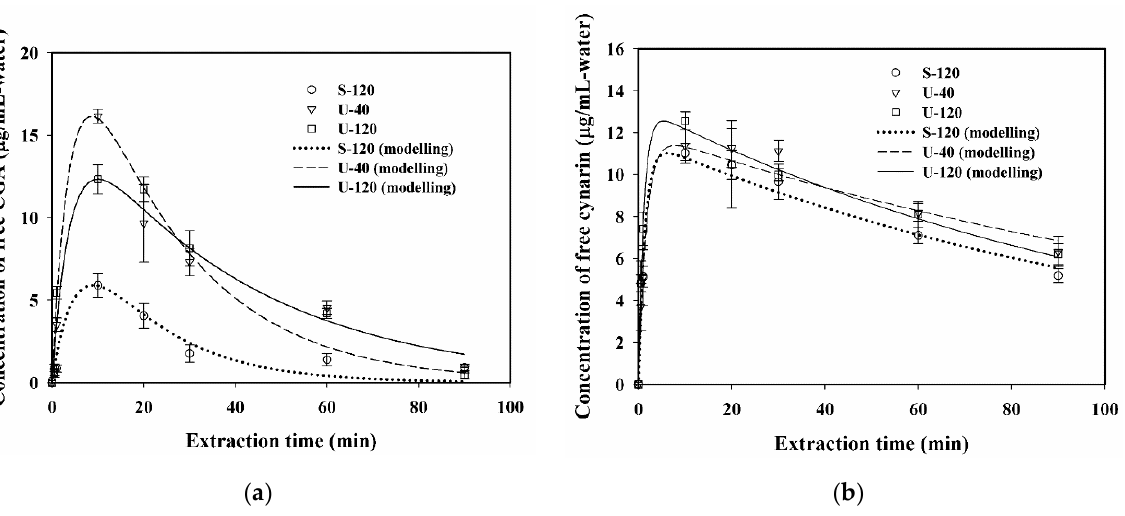
Figure 4. Plots of ( a ) concentration of free chlorogenic acid (CGA) and ( b ) concentration of free cynarin in water versus extraction time, and modelling the correlation of related kinetic parameters. Conditions: 50 °C and 1/30 (g/mL-water) of solid-to-liquid ratio for extraction modes of 120 rpm of shaking (S-120), 40 kHz/300 W of ultrasound (U-40), and 120 kHz/300 W of ultrasound (U-120). Data were expressed as mean ± standard deviations from triplicate experiments. Symbols: experimental data; lines: modelling results.